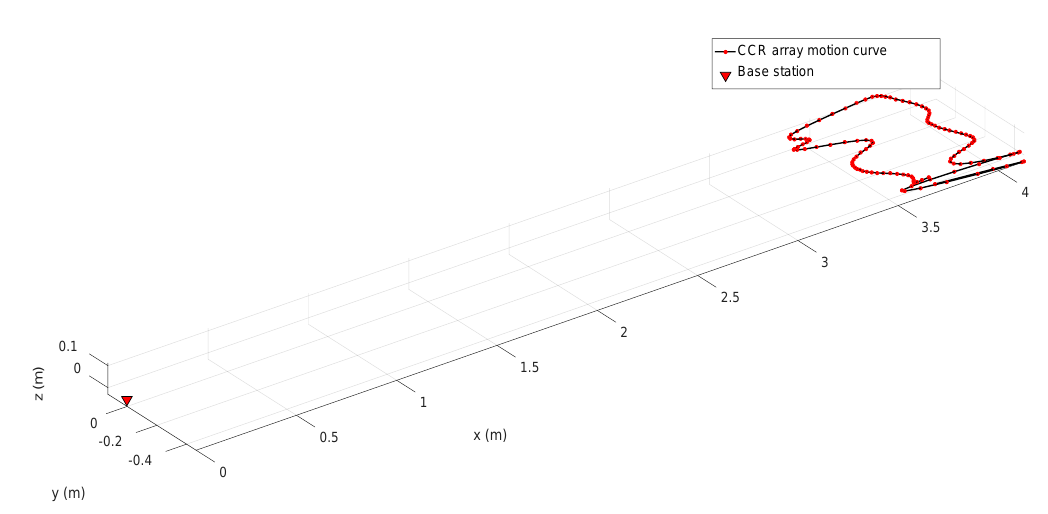
Figure 16. Tracking and localization experiment in the pool. (a) The base station emits laser beams and tracks the CRR; Bottom panels show the laser-tracking links of (b) 1# CCR (top CCR); (c) 2# CCR (middle CCR); and (d) 3# CCR (bottom CRR).